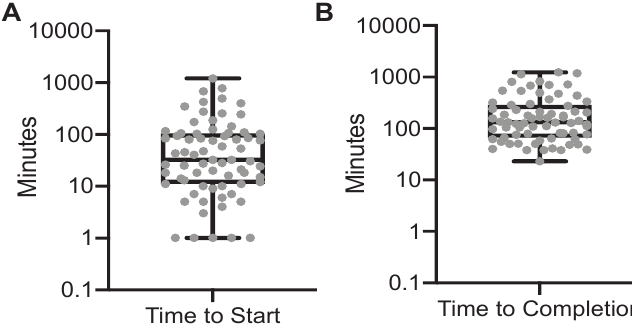
Figure 2. Distributions of times from positive COVID-19 test result when contact tracing begun at time of diagnosis in the emergency Figure 1. Distributions of times from positive test result to (A) department. (A) initiation of contact tracing and (B) investigation initiation of contact tracing and to (B) investigation completion completion plot ted on a log scale. Box-and-whisker boxes show plotted on a log scale. Box-and-whisker boxes show median and median and 25th–75th percentiles; whiskers indicate minimum 25 th to 75 th percentiles; whiskers indicate minimum and maximum and maximum values. Each individual case is plotted. values. Each individual case is